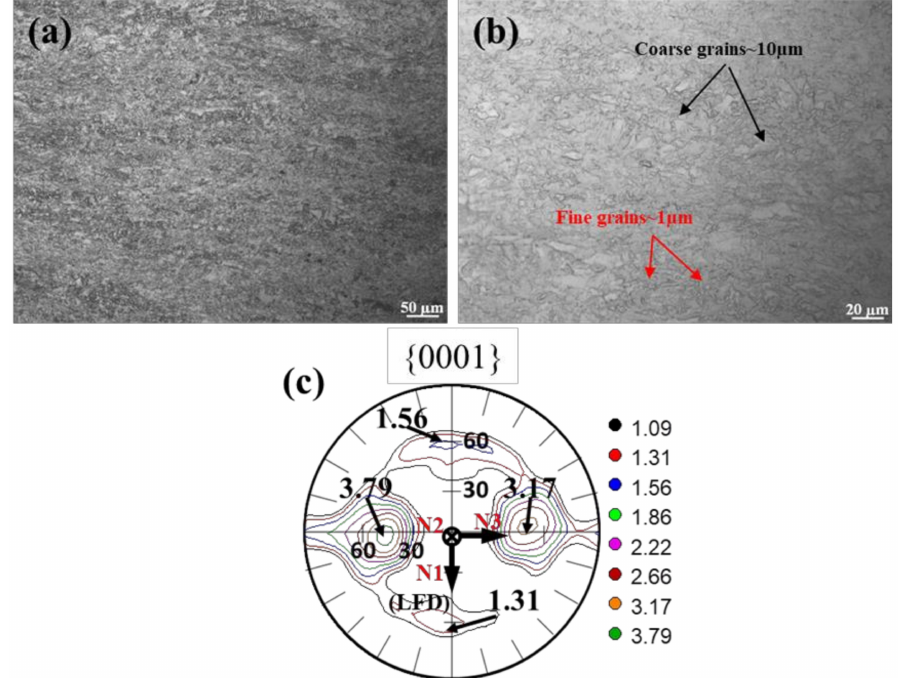
Figure 3. ( a ) Low magnification and ( b ) high magnification of OM as well as corresponding ( c ) {0001} macrotexture of MDIF100+100 sample of GW52 Mg alloy at the center location (~35